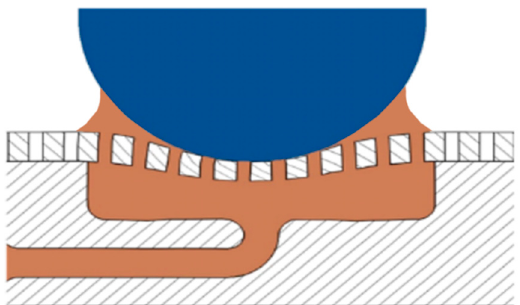
Figure 13. The mechanism of the pocket-textured surface sample under load.